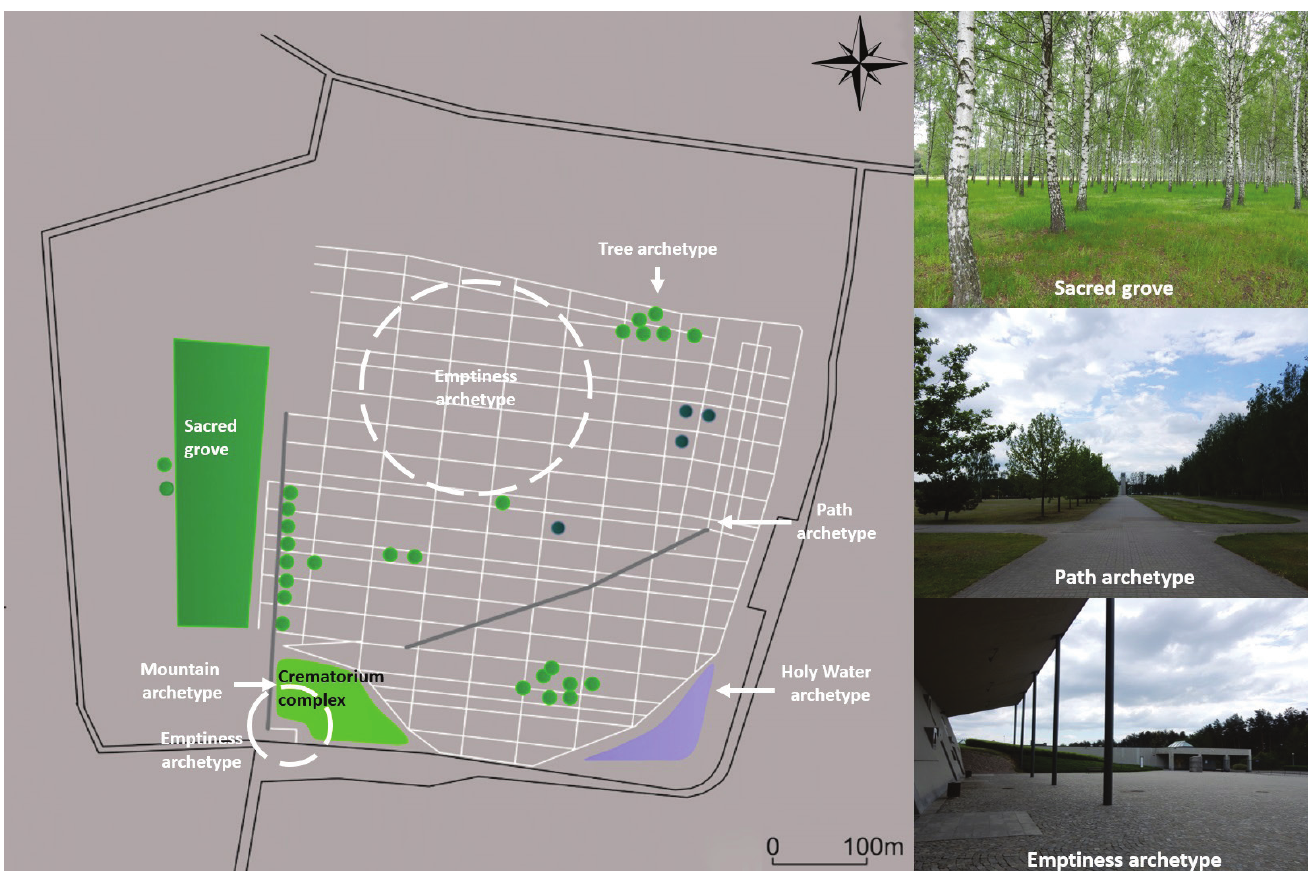
Figure 12. Spatial assumption with crematorium in Antoninów as an example of site that implement design solutions of multifaceted funerary landscape. Own